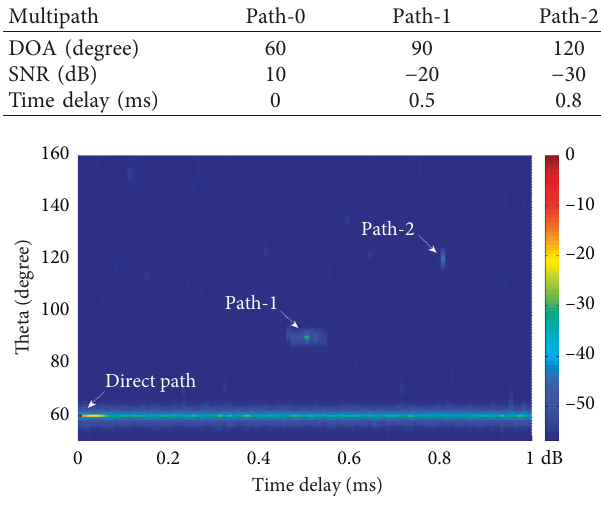
Table 4: Simulated parameters for examples 2 and 3.